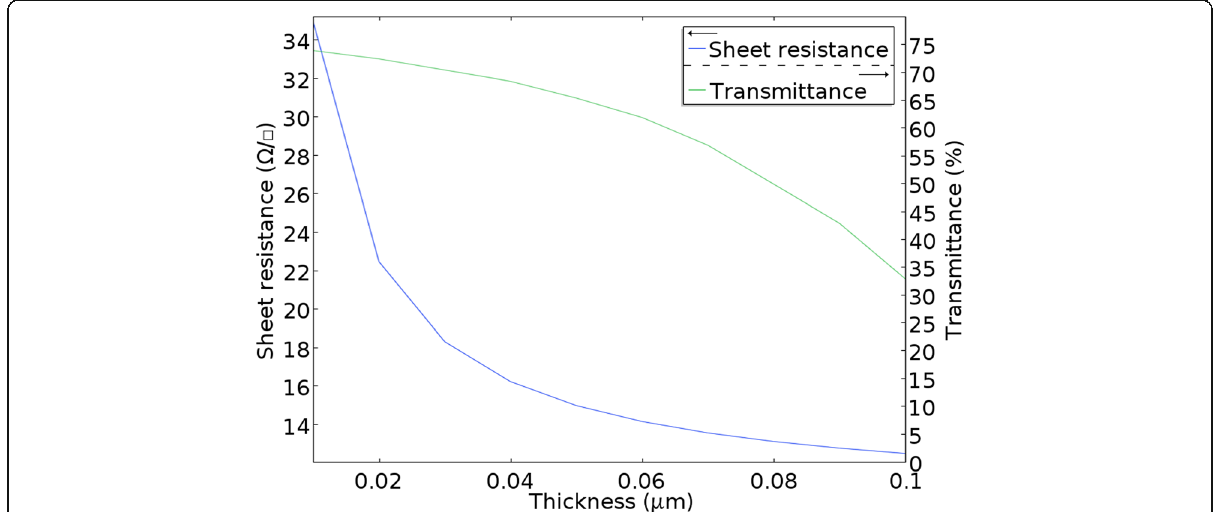
Fig. 4 Transmittance and sheet resistance vs. the AuNM thickness (at λ = 550 nm and W5 = 160